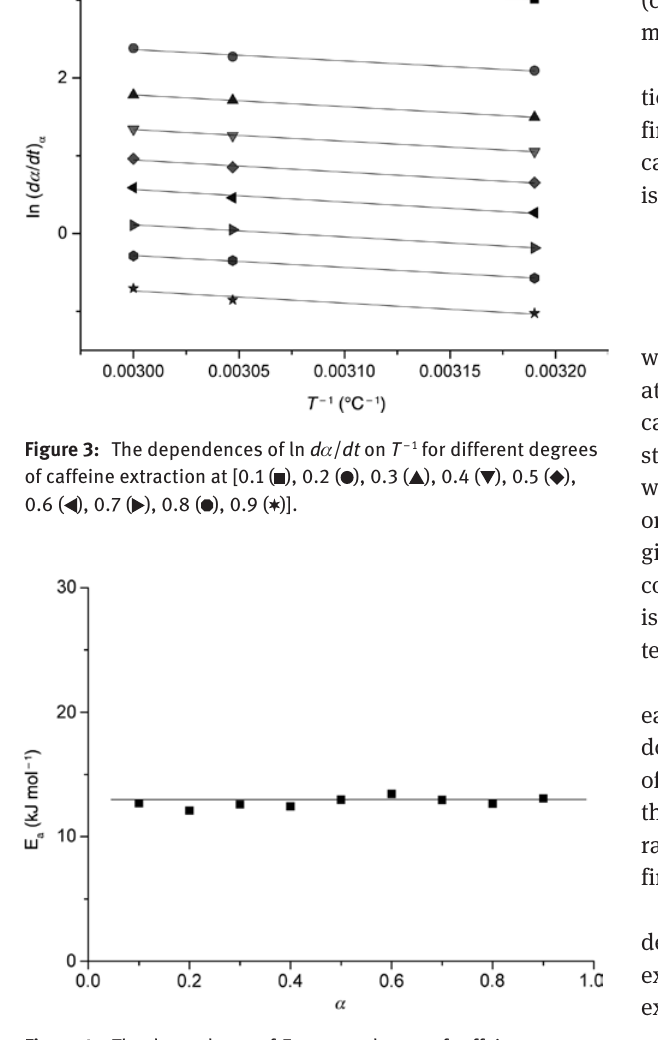
Figure 4: The dependence of E extraction.